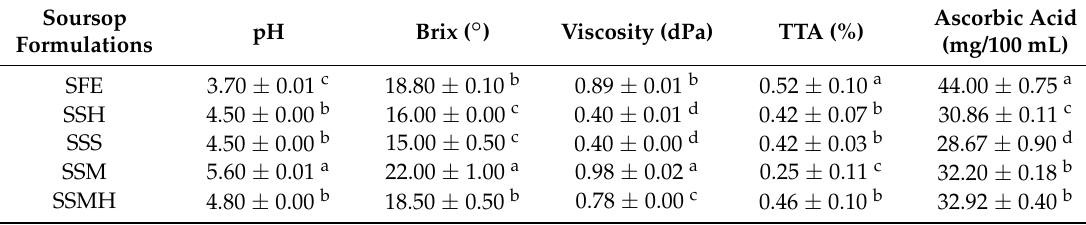
Table 2. Physicochemical compositions of soursop extract and